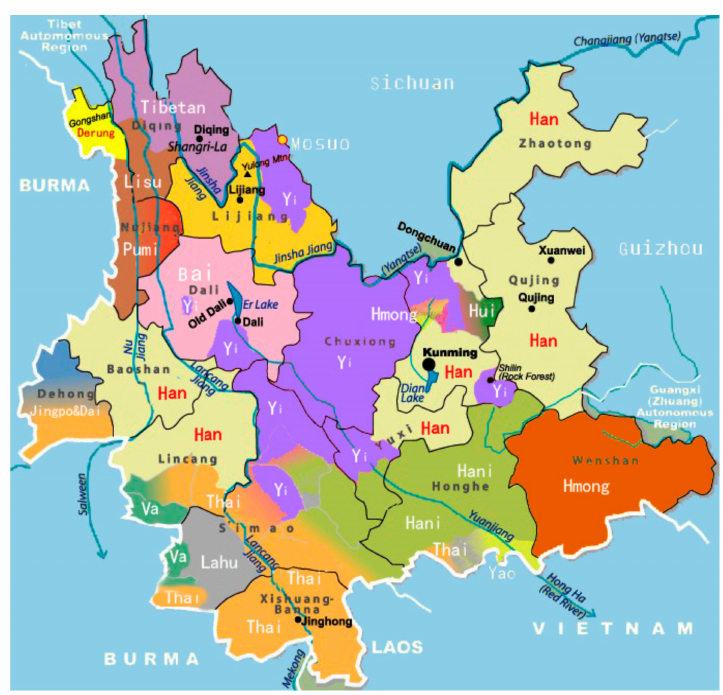
Figure 1. Ethnic diversity of Yunnan Province,